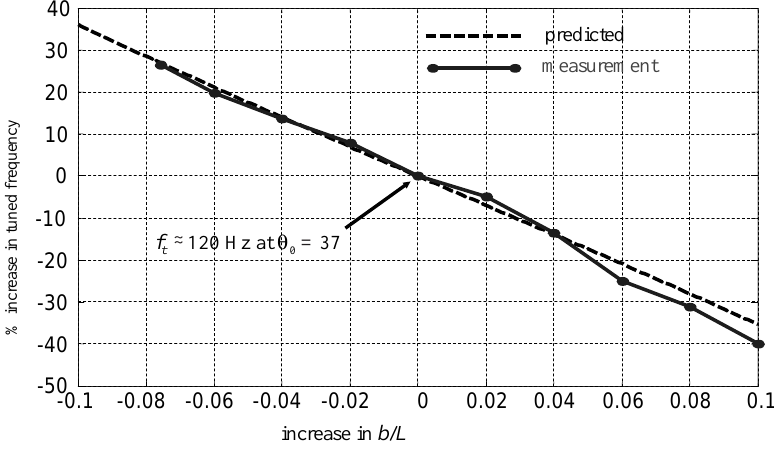
Fig. 8. Tuning characteristic of the prototype ATVA shown in Fig.